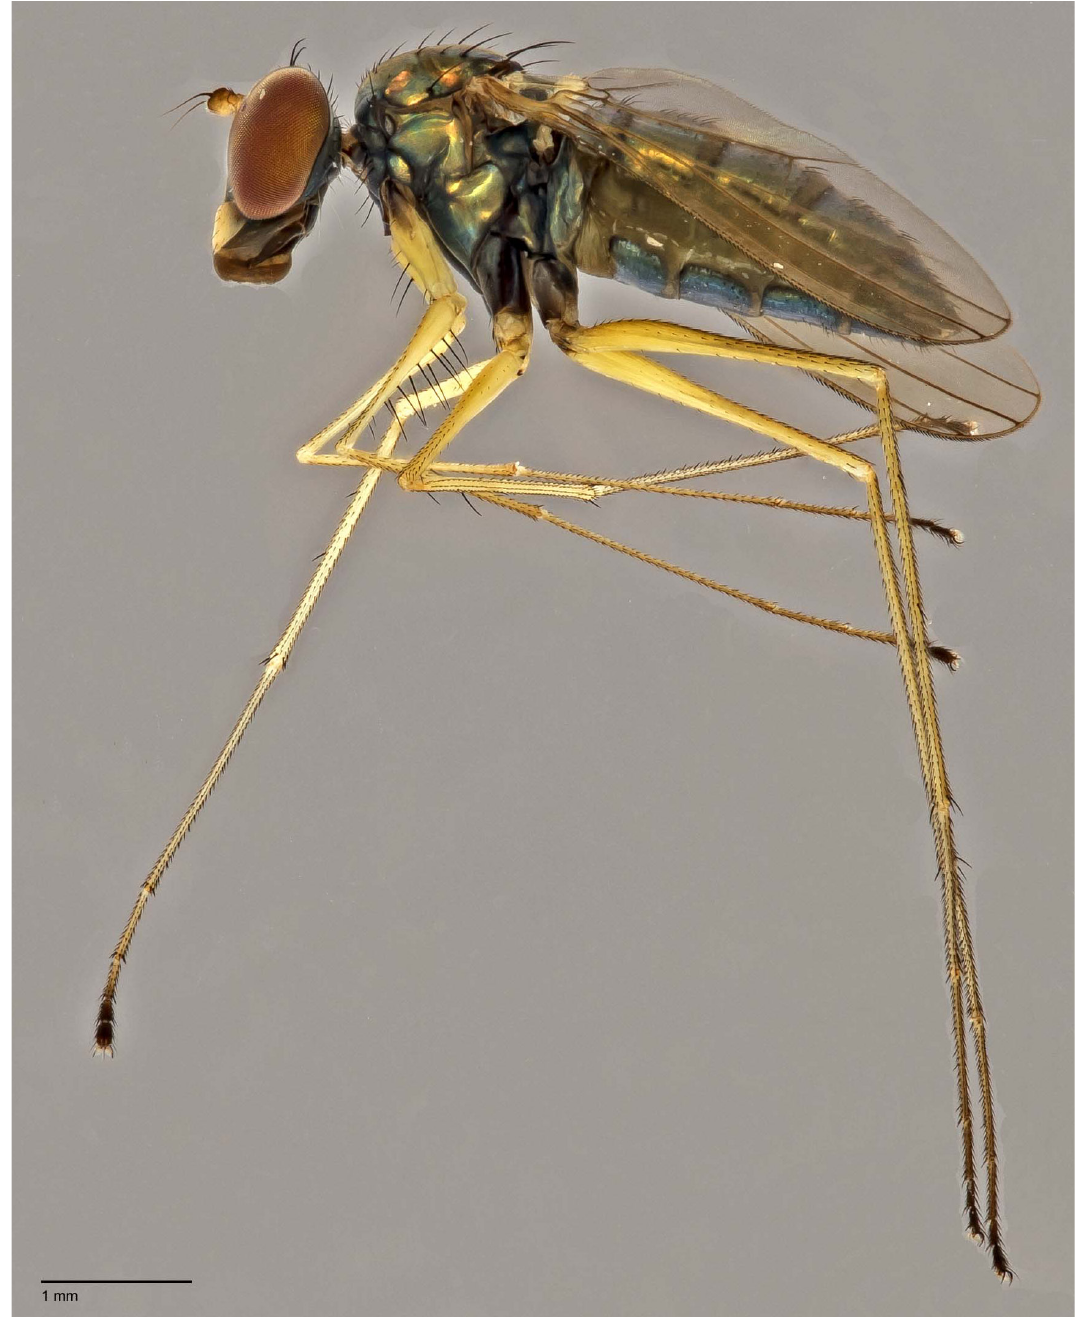
Fig. 26. Thinophilus spinatoides sp. nov., ♀,